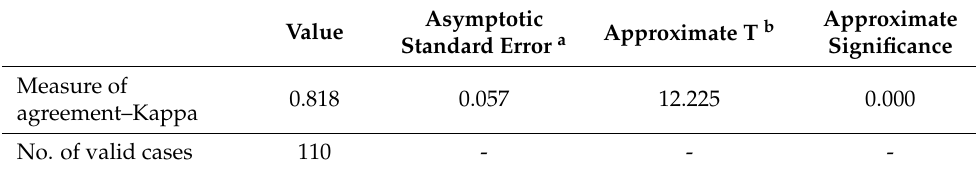
Table 10. Cohen’s Kappa